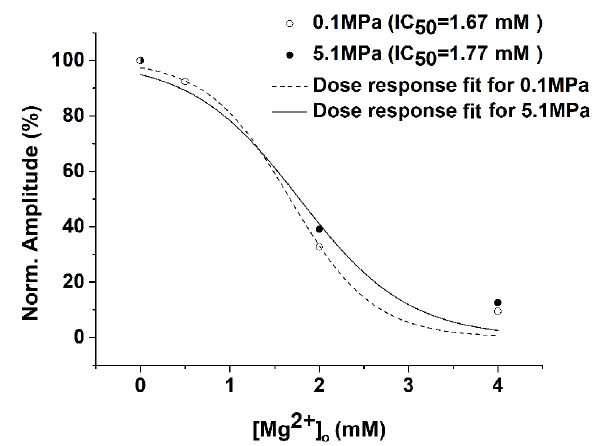
FIGURE 3 | Example of the HP He effect on the Mg 2 + dose-response curve. There were no significant changes in the dose-response curve and the IC 50 for the GluN1-1a + GluN2A subtype (measurements were performed on the same oocyte under control and HP He conditions). Current amplitudes of the receptor were normalized to its [Mg 2 + ] o = 0 response, and dose-response curve fit was performed for each